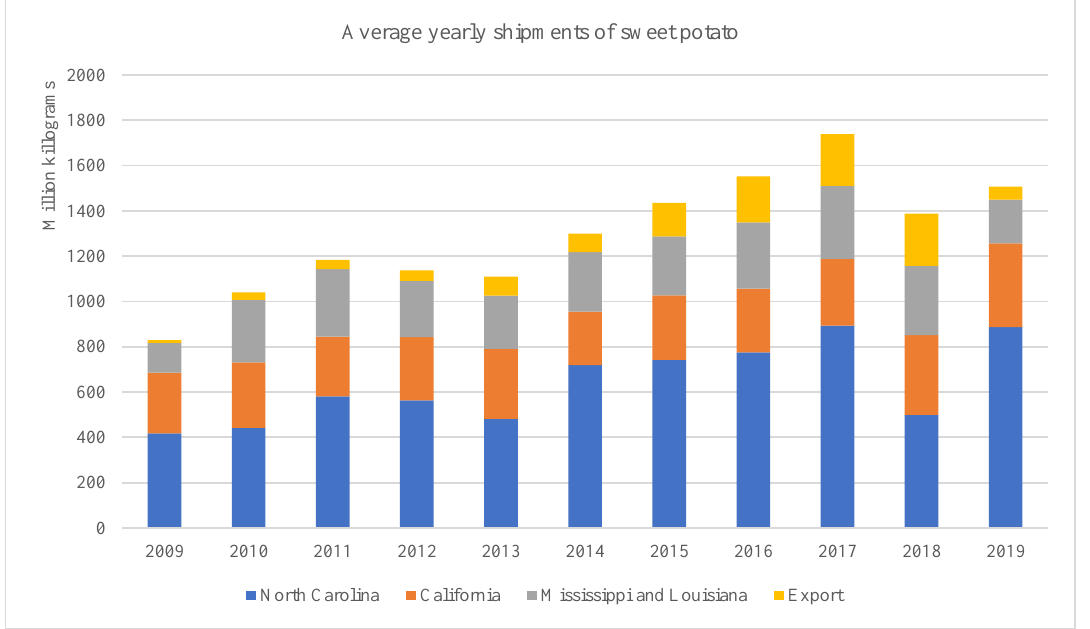
Figure 1. Average annual shipment of sweet potatoes by markets.